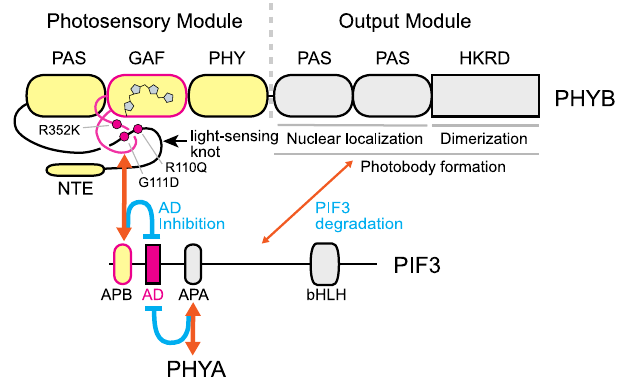
Fig. 9 Model of two structurally separable PHYB actions for inhibiting PIF3 stability and transactivation activity. Photoactivation of the N-terminal photosensory module induces the binding of PHYB ’ s light- sensing knot to PIF3 ’ s APB, thereby masking the transactivation activity of the adjacent PIF3 AD. In parallel, the C-terminal output module, which mediates photobody formation, interacts weakly with PIF3 in a light- independent manner to promote PIF3 degradation. The latter action requires the dimerization of the output module via HKRD. The orange lines represent the interactions between PHYB and PIF3. Binding of PHYA to APA also inhibits the activity of the PIF3 AD. The schematic of PHYB domain structure is modi fi ed from a model by Burgie and Viestra 12